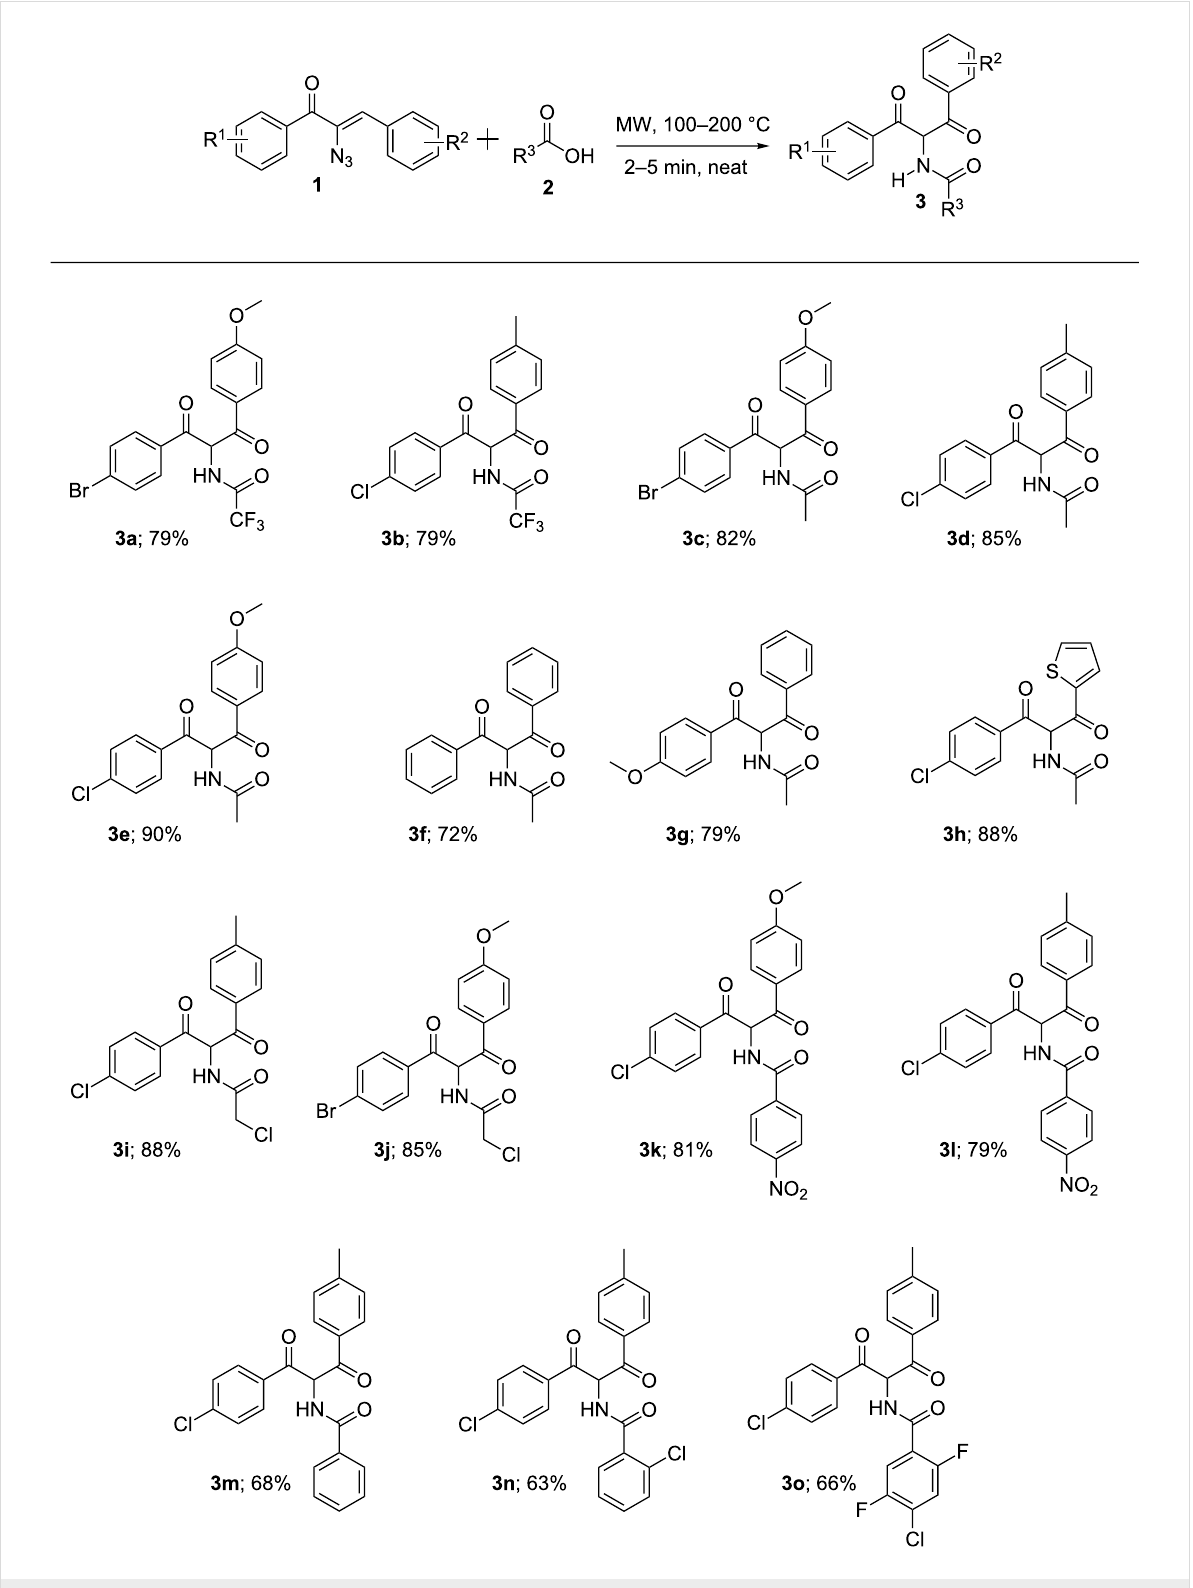
Figure 3: Synthesis of α -amido-1,3-diketone ( 3a–o ). Reaction conditions: α -azidochalcone 1 (1.0 equiv) and carboxylic acid 2 (1.0 equiv), 100–200 °C, 2–5